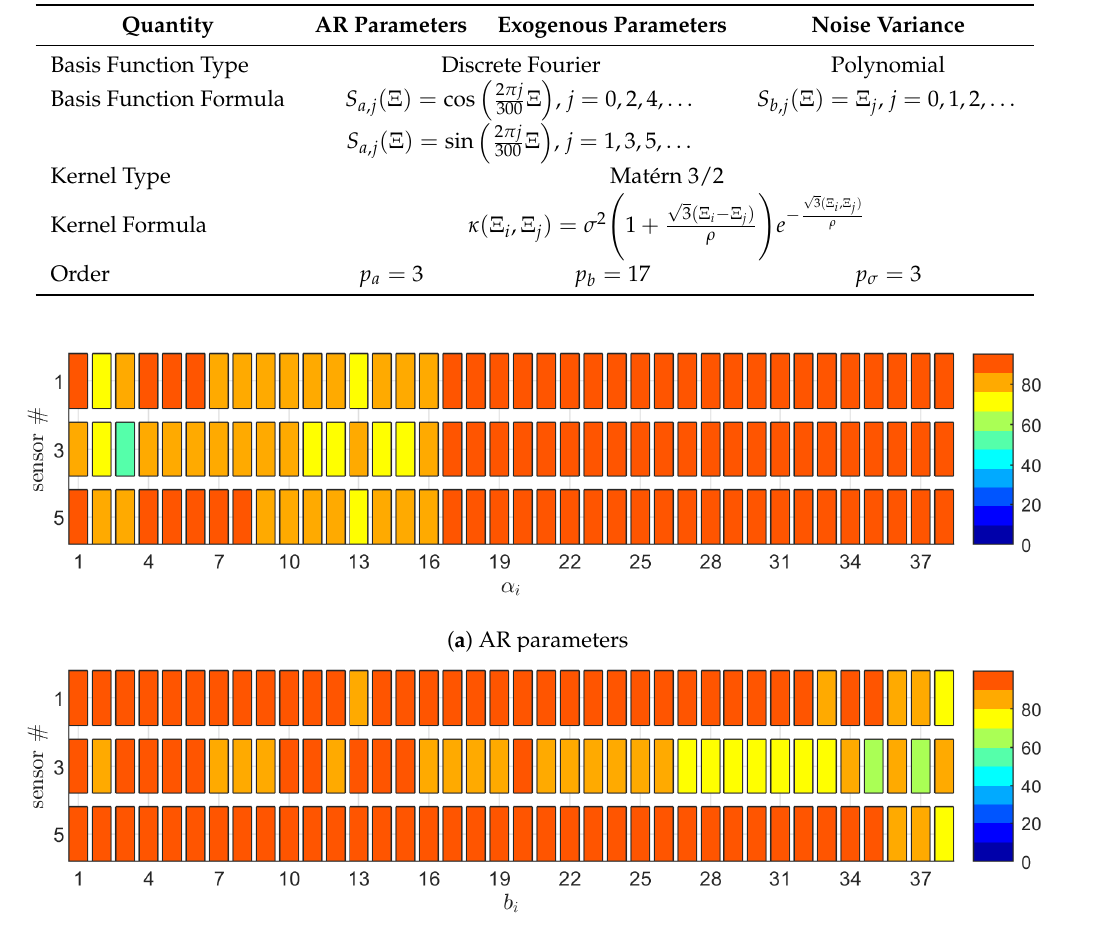
Table 2. Spring-mass-damper system: GPR basis functions, kernels and orders.